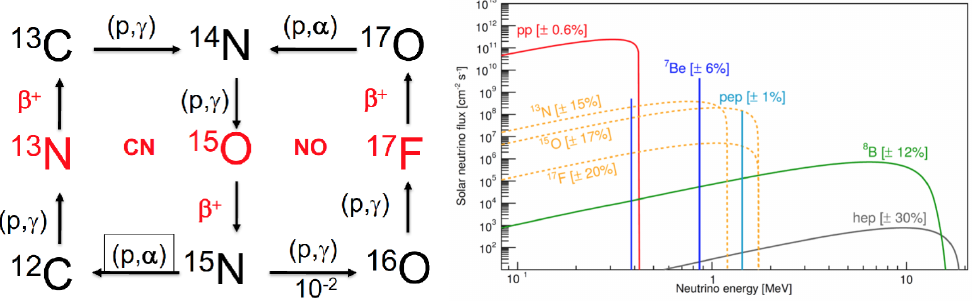
Figure 2: Left: the CNO solar fusion cycle. Right:the SSM solar neutrino spectrum.